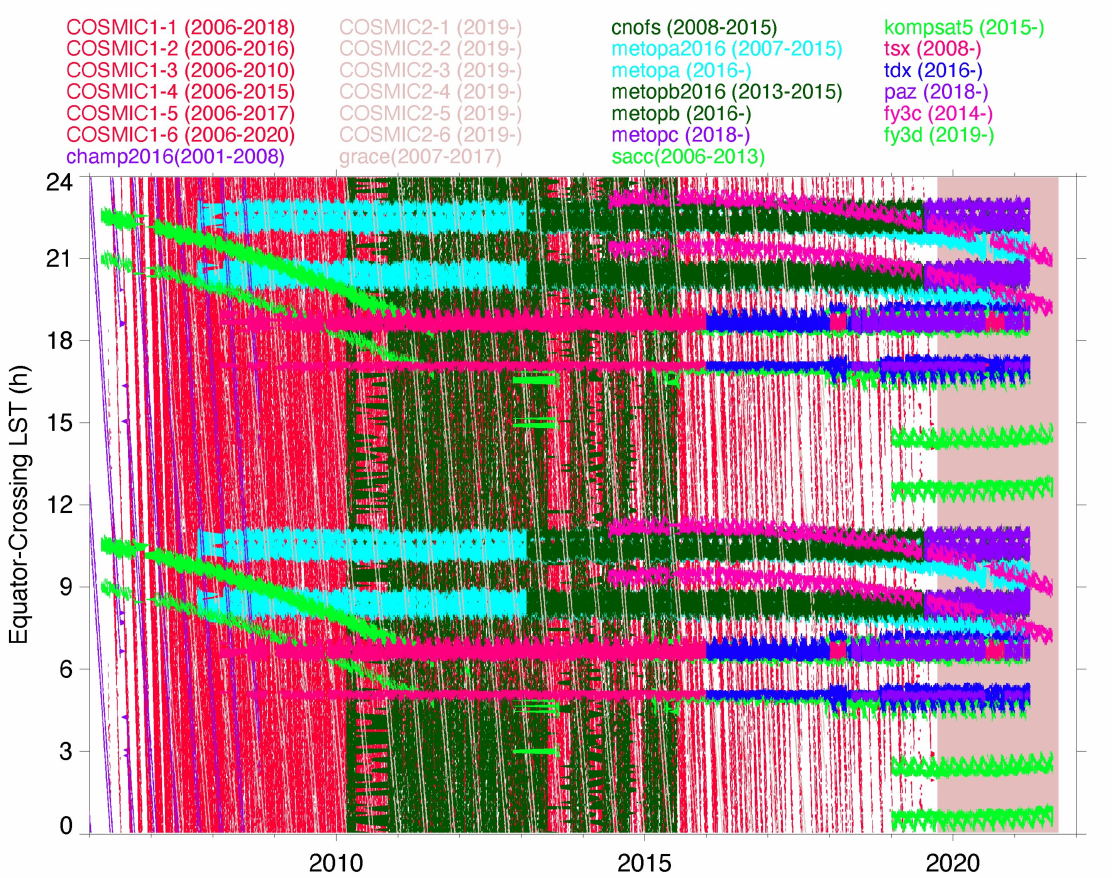
Figure A3. Time series of daily mean equator-crossing LSTs of the RO measurement from different missions. The LSTs from satellite’s ascending and descending orbits are separated roughly by 12 h. Each orbit node has two close LSTs separated by ~1.5 h, which comes from the RO measurements made by the fore and aft viewing antennas. Most of the modern RO instruments have at least two receivers to take measurements from the fore and aft